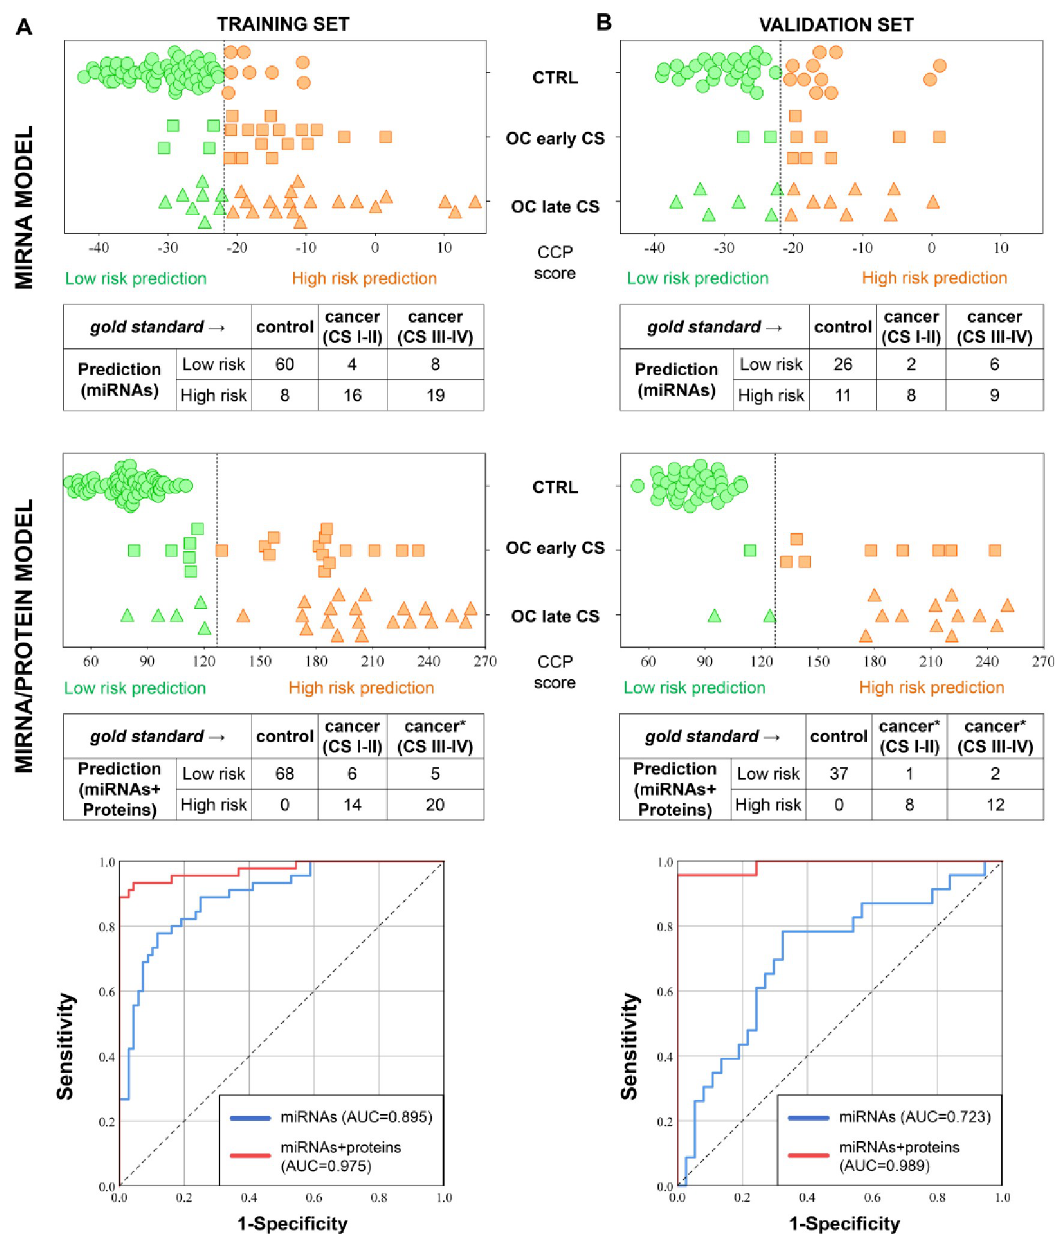
Fig 3. Training and validation of the ovarian cancer diagnostic models. A. Application of the miRNA-classifier (miR-141-3p and miR-320b) and the miRNA/protein-classifier (miR-320b, miR-141-3p, CA-125 and HE4) in the Training Set (n = 115) and the resulted classification and AUC. B. Application of the same classifier in the Validation Set (n = 62). The dotted line in the dot-plot represents the threshold, above of which a malignant status would be predicted (low-risk prediction in green and high-risk prediction in orange). Sample size: 105 Controls (Training n = 68; Discovery n = 37); 30 Early stages (I-II) ovarian cancer (Training n = 20; Discovery n = 10); 42 Late stages (III-IV) ovarian cancer (Training n = 27; Discovery n = 15). � HE4/CA-125 levels are not available for four OC cases (1 early and 3 late stages). CCP: Compound Covariate Predictor; AUC: area under the ROC curve; CS: clinical stages. The dotted line in the ROC curve represents the random reference (AUC = 0.5).